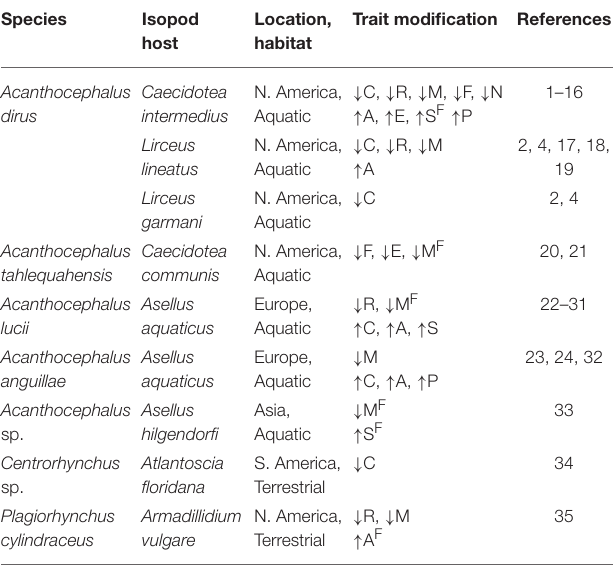
TABLE 1 | Examples of acanthocephalan-related modification of behavioral and physiological traits of isopod hosts. Species Isopod Location, host